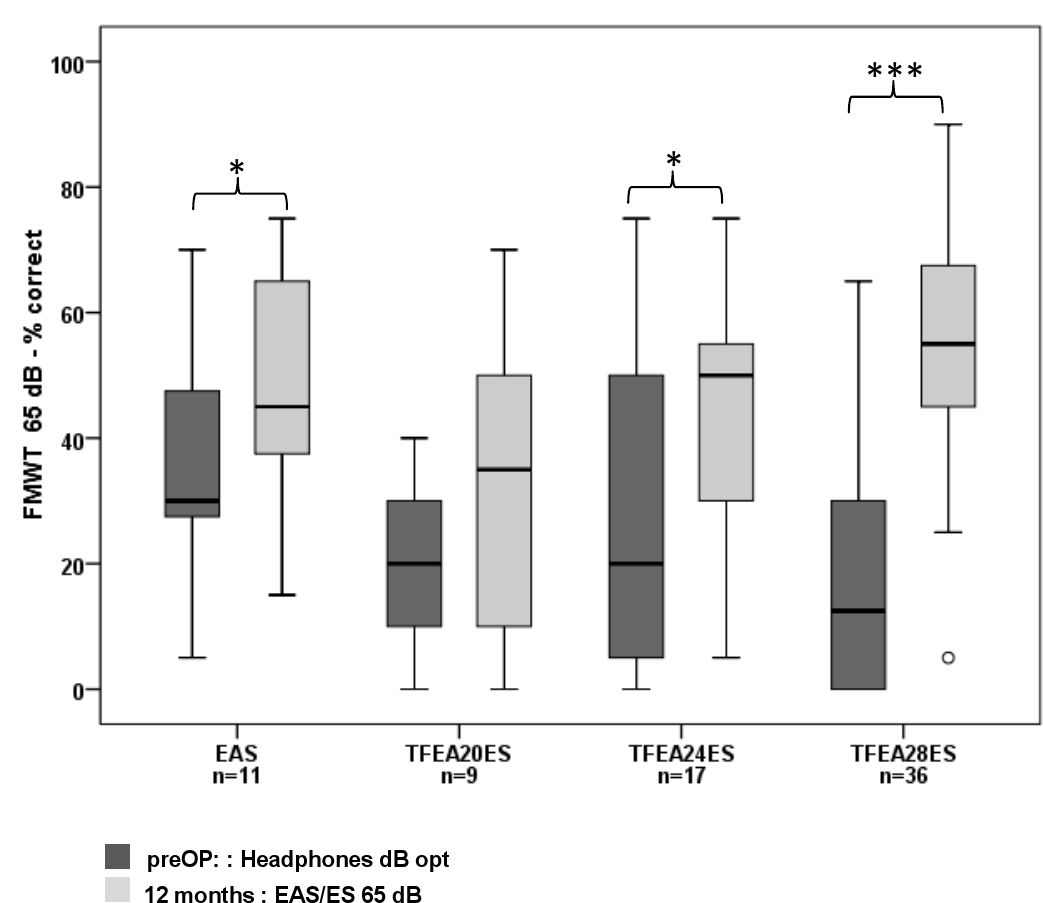
Figure 3. Median, interquartile, minimum and maximum FMWT scores preoperatively (unaided at optimum dB SPL, tested with headphones) and 12-months postoperatively (i.e., CI use). Significant differences are marked with * for p < 0.05, and *** for p < 0.001.